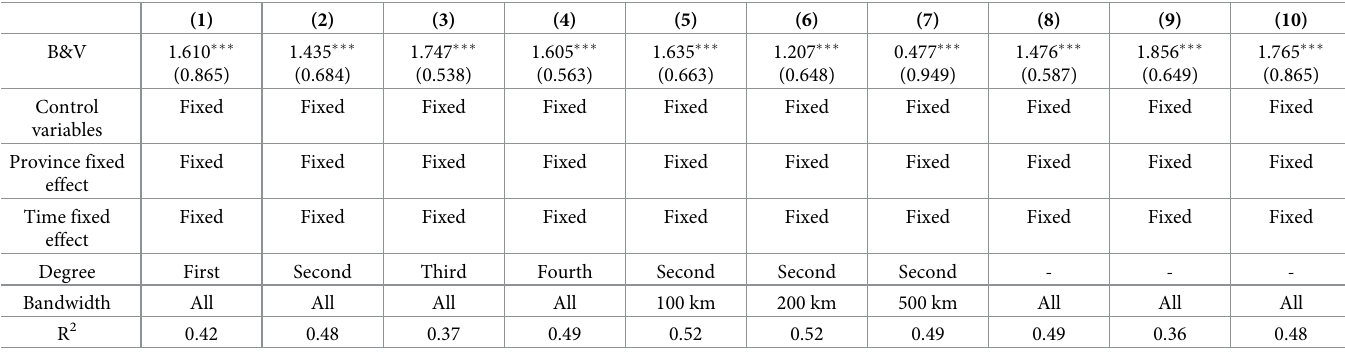
Table 5. Estimation results of the nonparametric estimation